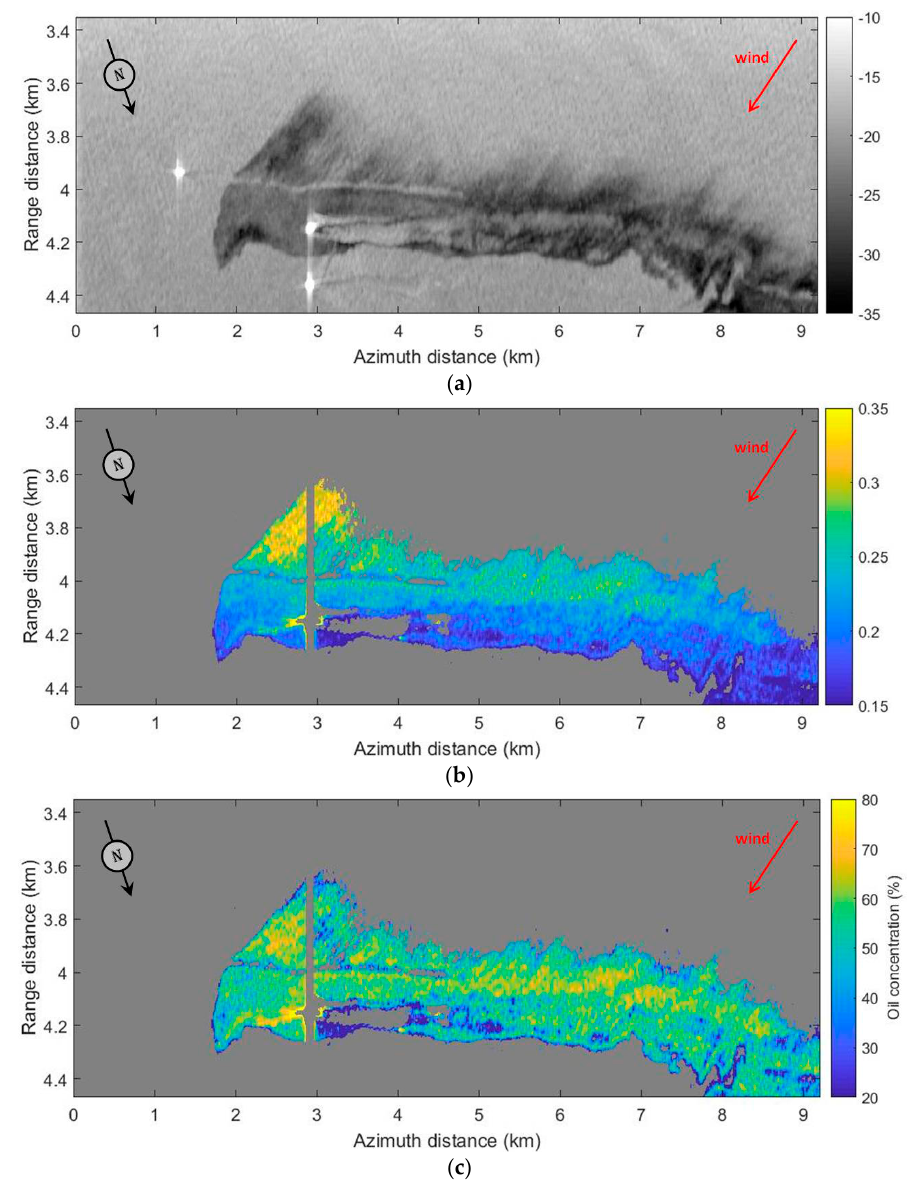
Figure 11. SETHI NOFO’2015 10:02 UTC. ( a ) L-band VV-pol image; ( b ) polarization ratio [0.15 0.35]; ( c ) oil concentration map [20 80%]—multi-look 21 × 21.